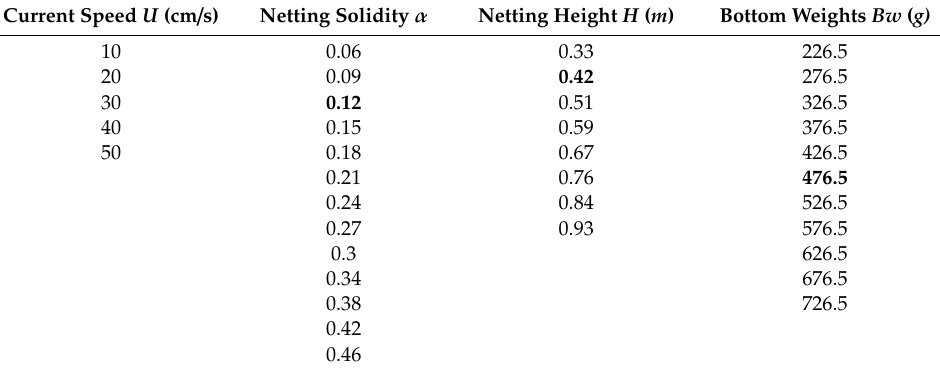
Table 2. Design parameters of net cage varied in the numerical